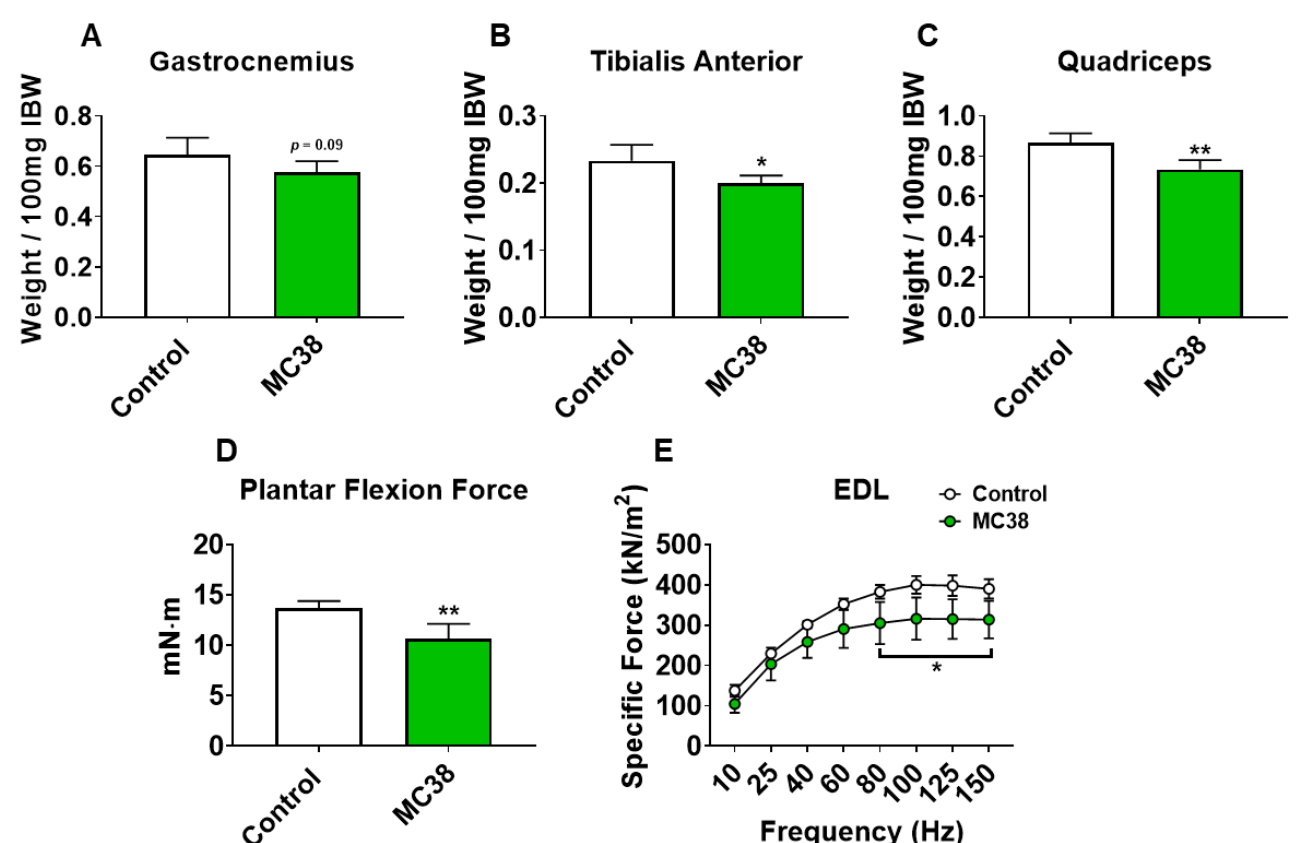
Figure 2. Growth of subcutaneous MC38 tumors causes muscle wasting and weakness. ( A – C ) Gastrocnemius ( A ), tibialis anterior ( B ) and quadricep ( C ) weights normalized to initial body weight (IBW) of C57BL/6 male mice (8 weeks) subcutaneously injected with MC38 tumor cells (1.0 × 10 6 cells/mouse in sterile PBS: MC38) or an equal volume of vehicle (control) ( n = 5). In vivo plantarflexion force assessment, reported as absolute force (expressed as mN · m) ( D ). Assessment of ex vivo muscle contractility of extensor digitorum longus muscles, reported as specific ex vivo force (expressed as kN/m 2 ) ( E ). Data presented as mean ± s.d. * p < 0.05, ** p < 0.01 vs.